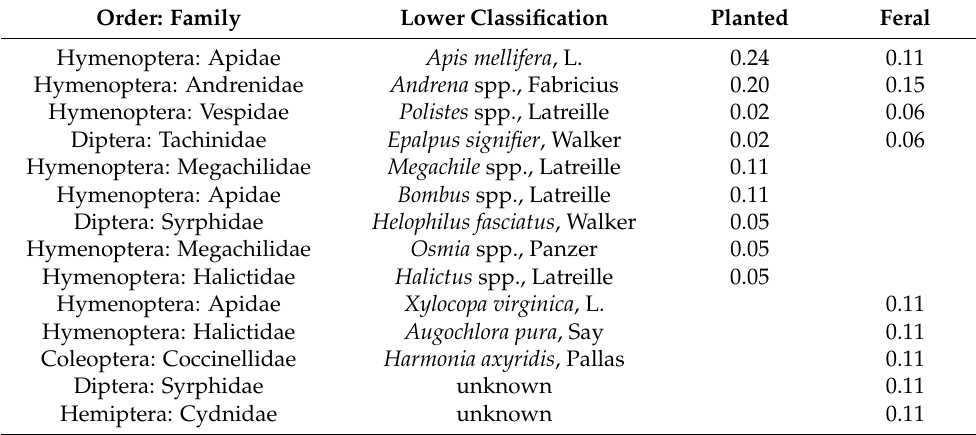
Figure 4. Overlap of planted (triangles) and feral (circles) communities using Principle Components Analysis suggests low turnover and similar composition of taxa on planted and feral trees ( p = 0.493). Table 2. Dufrene-Legendre Indicator Species Values of taxa collected from planted and feral P. calleryana . None were statistically significant indicators of either tree type.